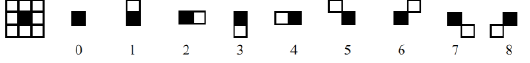
Figure 3. Second-order neighborhood system and its division into cliques.